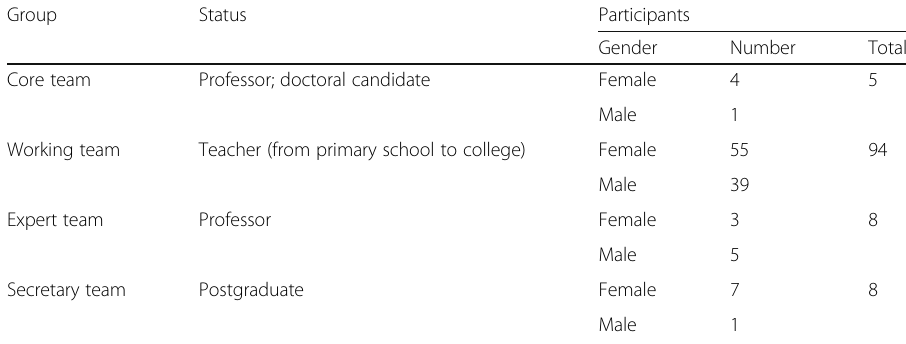
Table 2 Participant information of the four groups